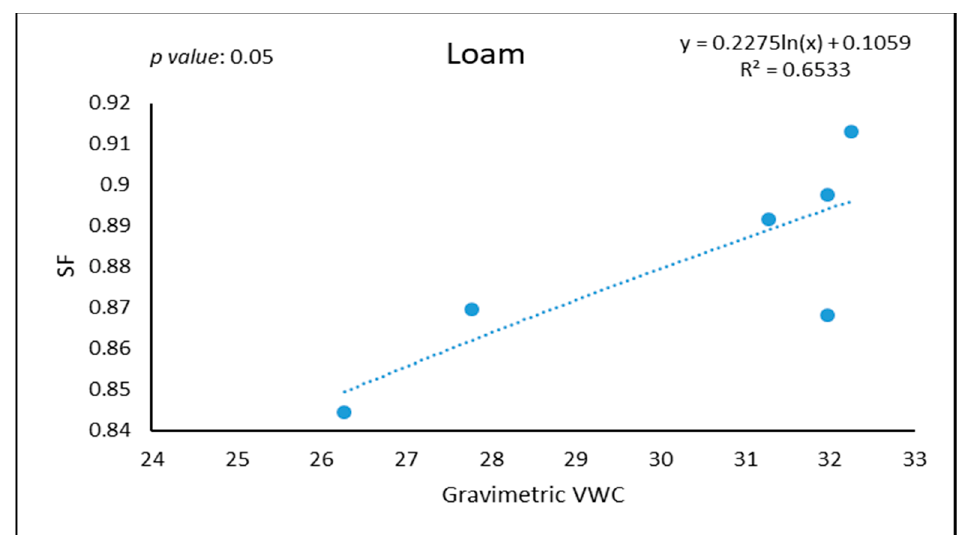
Figure 12. Loam Field VWC compared with derived VWC.